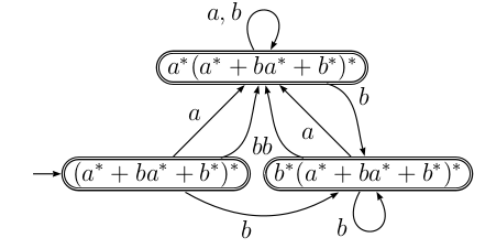
Figure 3. The equation automaton E E